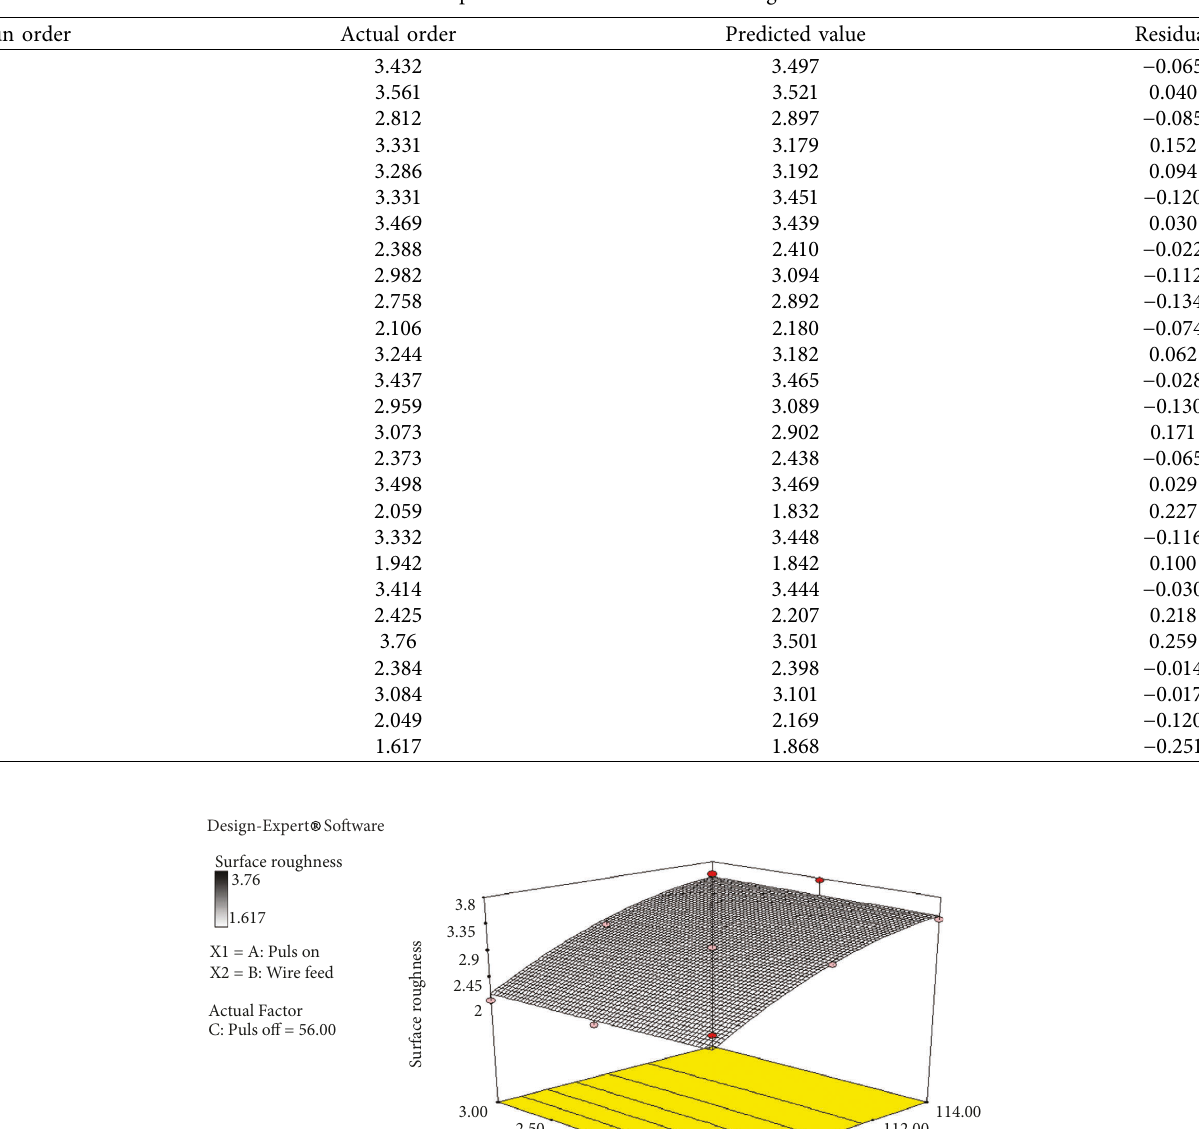
Table 7: Optimization results in surface roughness.